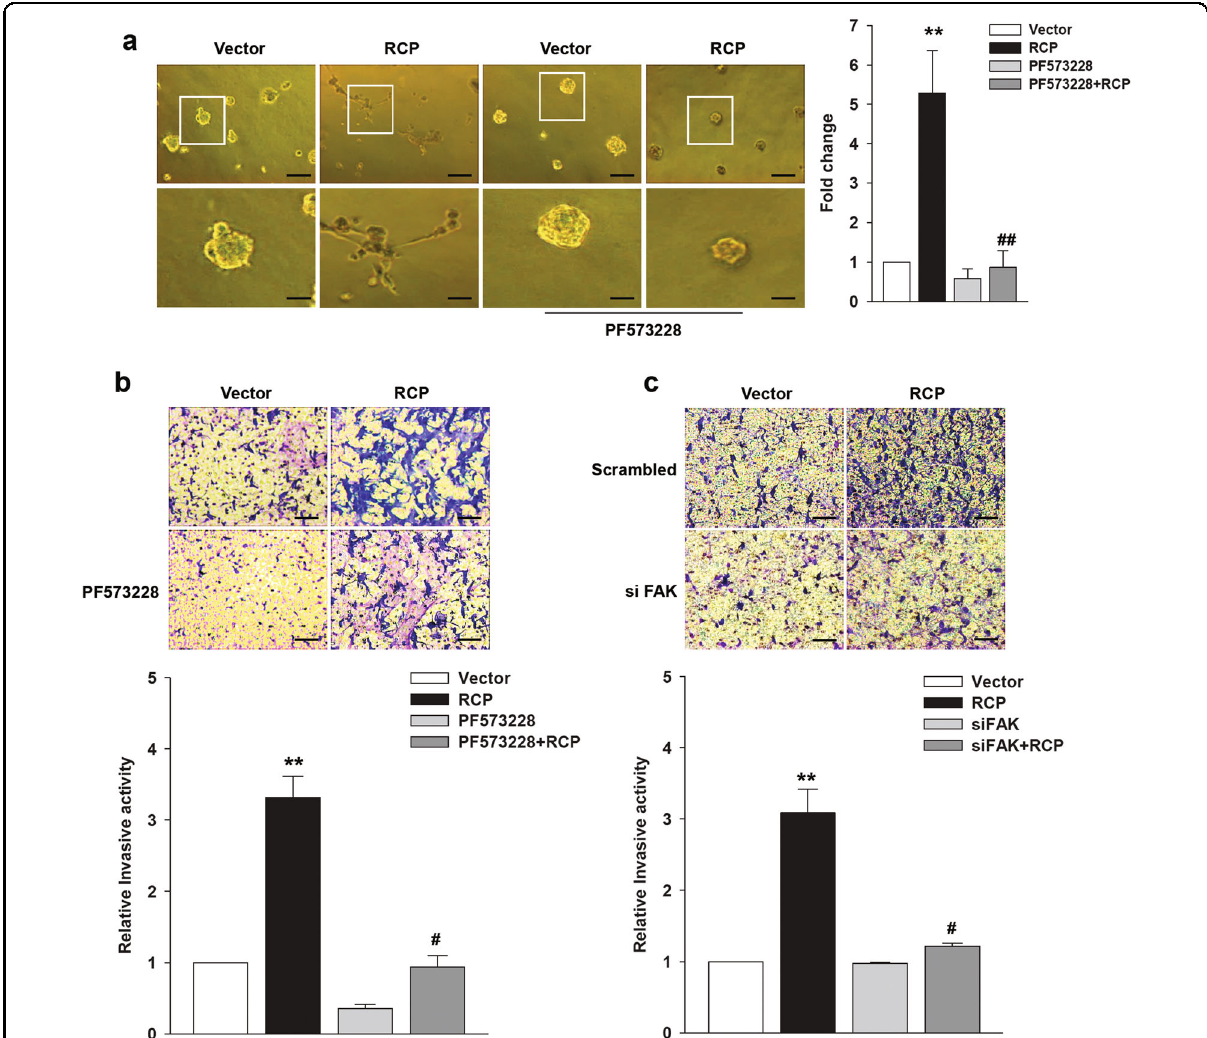
Fig. 2 FAK is important for ovarian cancer cell invasion. a Phase contrast images showing the morphology of stably transfected SKOV-3 cells with the indicated vectors followed by treatment with PF573228 (10 μ M) for 4 days on Matrigel. Image original magni fi cation ×100; scale bar, 200 μ m. Inset shows higher magni fi cation (left). The number of branches was counted and quanti fi ed (right); mean ± s.d. ** P < 0.01 vs. the control vector, ## P < 0.01 vs. RCP overexpression only. b SKOV-3 cells were transfected with the indicated vectors for 48 h followed by treatment with PF573228 (10 μ M) for 1 h. Invasion assay (mean ± s.d. **P < 0.01 vs. the control vector, # P < 0.05 vs. RCP overexpression only). c SKOV-3 cells were co-transfected with the indicated vectors and siRNAs for 48 h prior to invasion assays (mean ± s.d. ** P < 0.01 vs. the control vector, # P < 0.05 vs. RCP overexpression with scrambled siRNA). Original magni fi cation, ×200; scale bar, 200 μ m. All experiments were repeated three